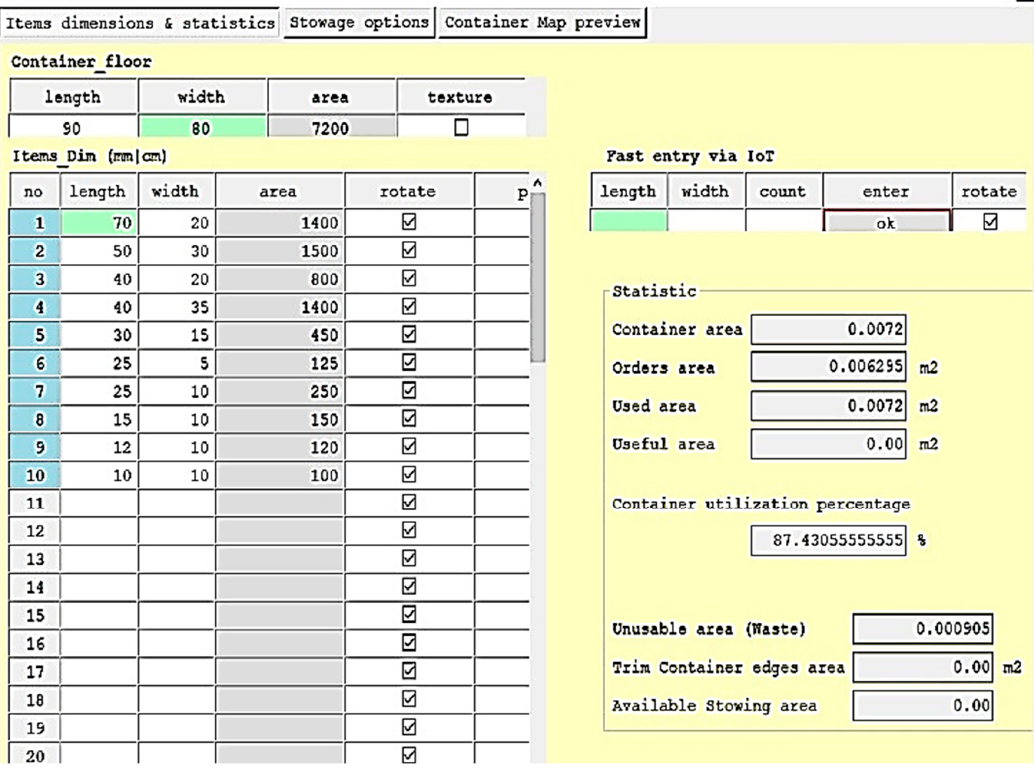
Figure A5. The stowage map for seven objects by the camel algorithm optimization for first station on the distribution path.